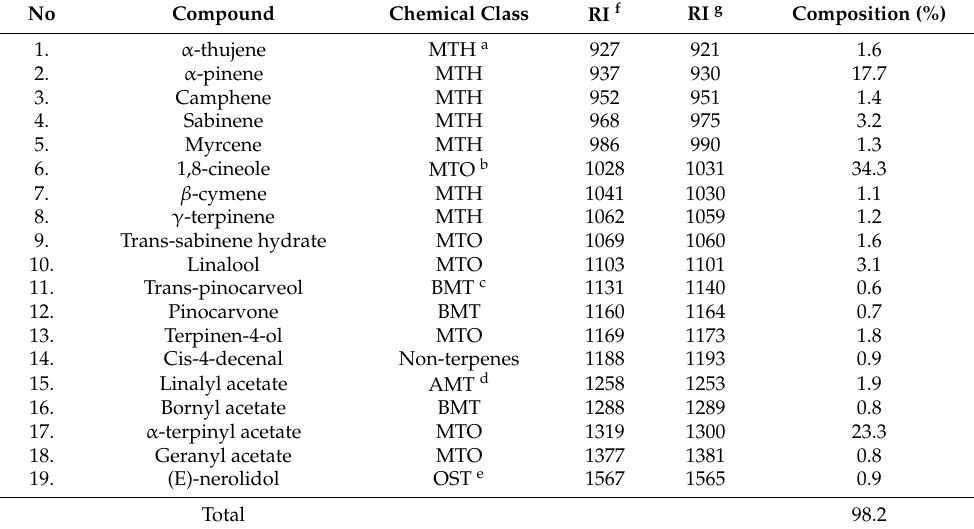
Table 1. The output results of the GC/MS analysis of Elettaria cardamomum essential oil.